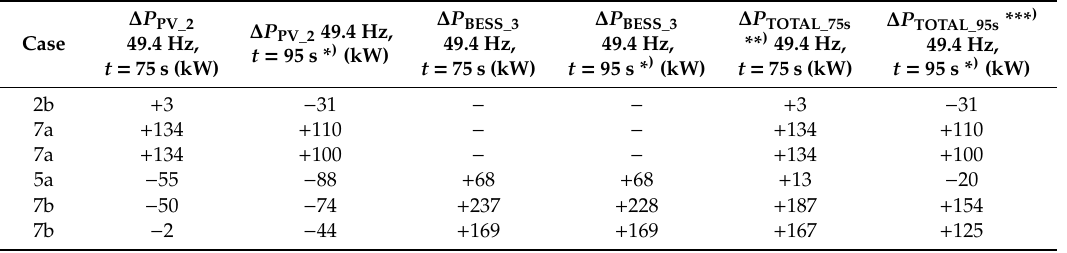
Table 9. Provided frequency support by PV 2 and BESS 3 in di ff erent cases during simulated under-frequency (49.4 Hz) events (see also Tables 7 and 8).